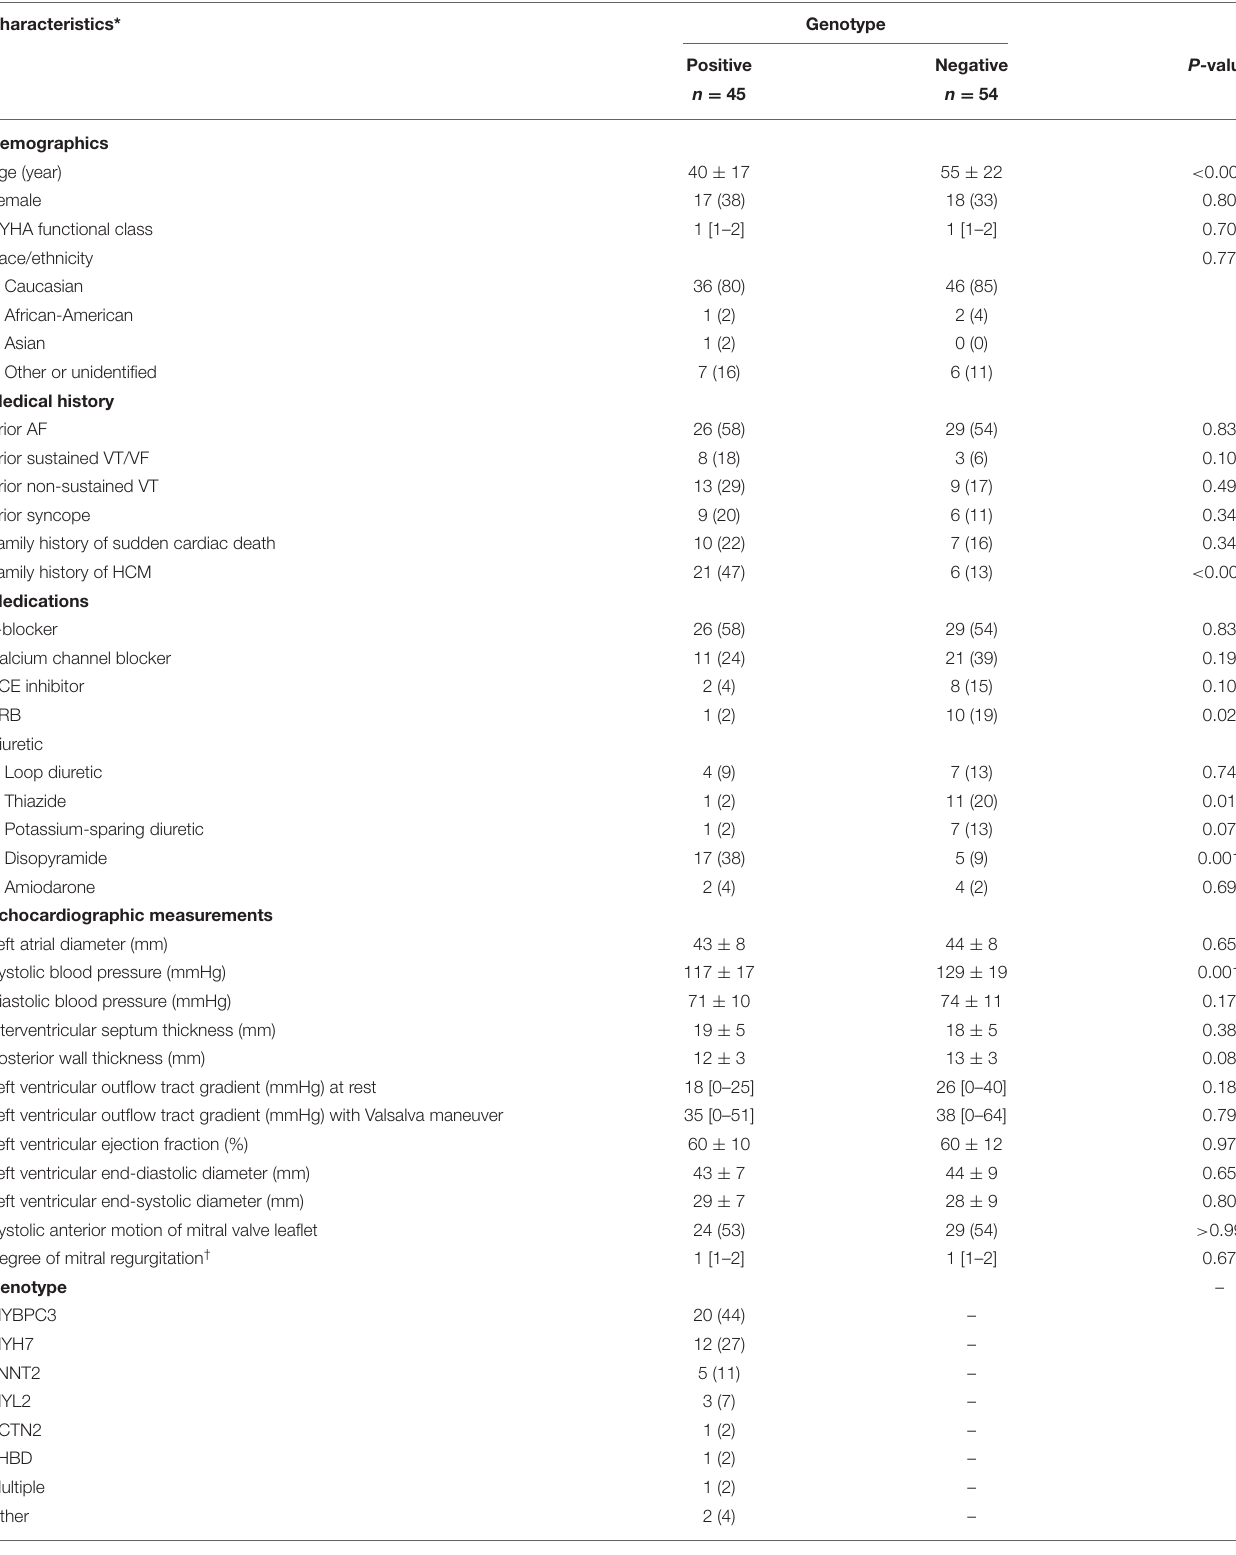
TABLE 1 | Baseline clinical characteristics of the study